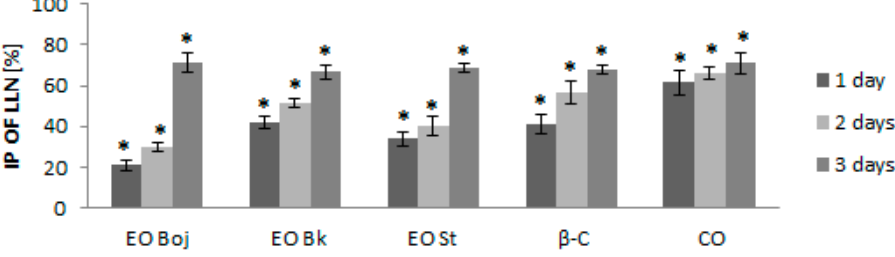
Figure 4. Inhibition percentage (IP) of local lesion number (LLN) on the leaves of Chenopodium quinoa plants inoculated with Cucumber mosaic virus containing associated satellite RNA (CMVsat). Prior to inoculation, plants were sprayed with essential oil (EO) of Micromeria croatica from the localities Bojinac (Boj), Ba č i ć kuk (Bk) and Stupa č inovo (St), β‐ caryophyllene ( β‐ C) and caryophyllene oxide (CO) for 1, 2 or 3 consecutive days. Control plants were inoculated with virus inocula without EO or oil components. Ten to fifteen experimental plants (four leaves per plant) were inoculated in each group. Values are expressed as the mean value ± SD calculated based on three independent evaluations (n = 3). The asterisk (*) denotes significant inhibition of local lesions number compared to the control ( p < 0.05). Based on this promising antiviral activity of EO of M. croatica in local host plants, several additional parameters were examined to further clarify its antiviral activity. According to our knowledge, the effect of EOs on virus replication in systemic host plant has not yet been tested. With the aim of determining whether the above treatments affect the spread of the virus in systemic host plants, virus concentrations were compared in upper, new ‐ grown leaves of EO ‐ treated and untreated Nicotiana megalosiphon plants continuously over seven days post inoculation (p.i.). In that sense, systemic host plants were: 1. simultaneously inoculated with virus and EO/DC of oil; 2. treated with EO/DC three days prior to virus inoculation; or 3. continuously treated with EO/DC three days prior and seven days after virus inoculation. The virus concentration was determined in systemically infected upper leaves collected at 1, 3, 4 and 7 days p.i. to provide complete information on viral dynamics possible influenced by the EO.